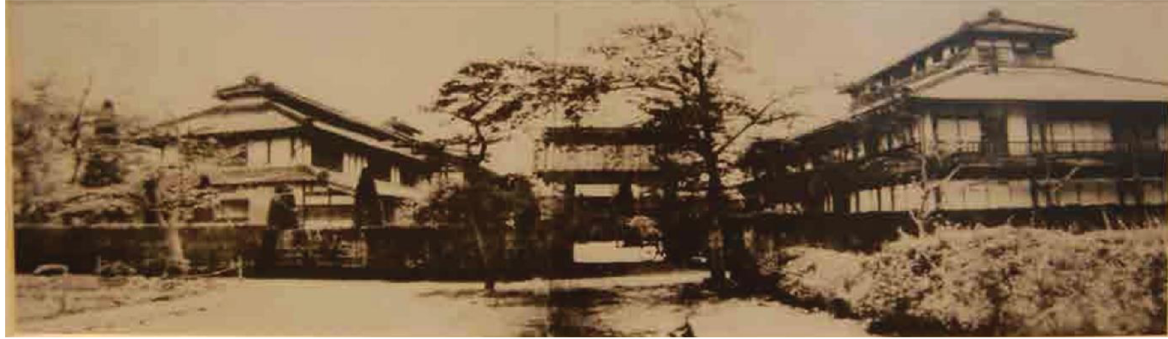
Fig. 2 Tajima Yahei Sericulture Farm in the early twentieth century. View from the east gate. Left: K ō getsu-ro . Right: Shin-sanshitsu (Source: Agency for Cultural Affairs 2013)